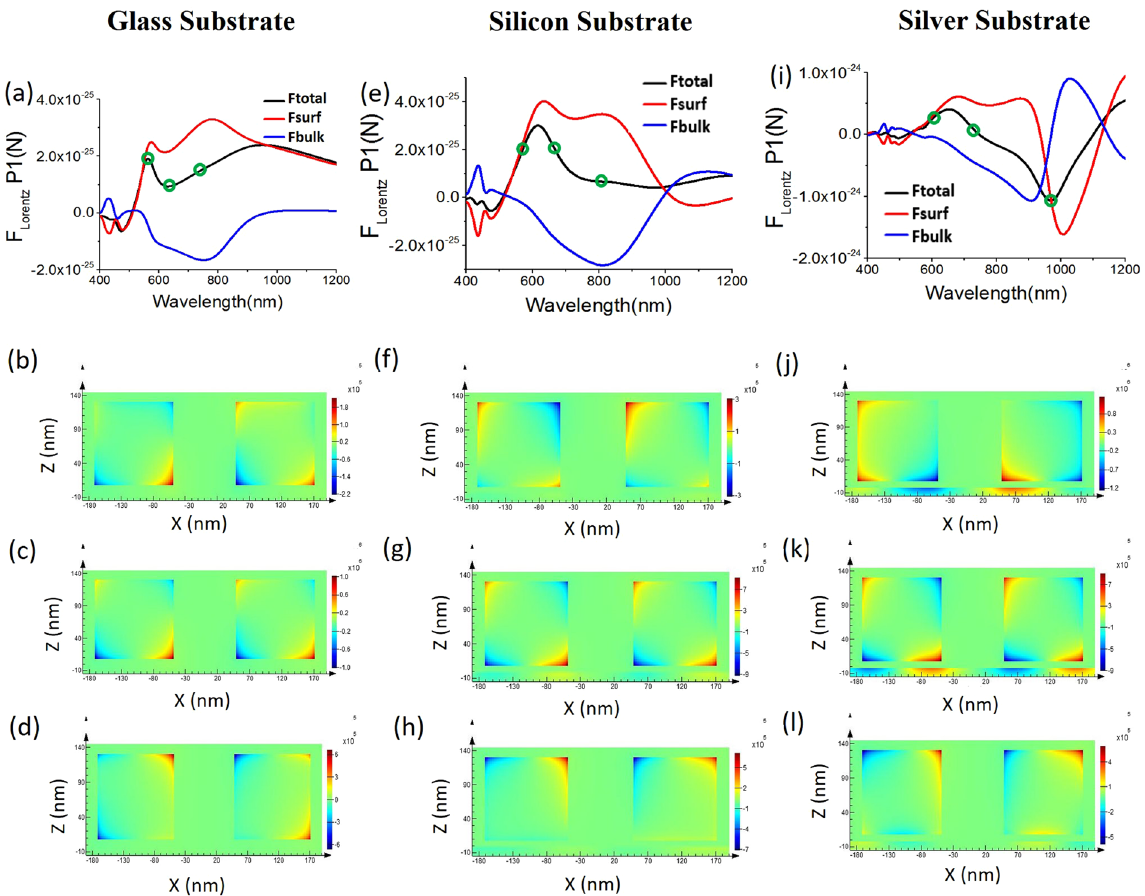
Figure 4. For the cases of different substrates, Lorentz force components and the steady state current ( J y ) of two silver cubes along with the substrate. First row represents the Lorentz force components: surface force, bulk force [cf. Eqs (5) and (6) in ‘METHODS’ section] and total force [cf. Eqs (3) and (4) in ‘METHODS’ section] only on cube-1 (left cube, denoted as P1). ‘ ° ’ represents the chosen wavelengths for which the steady state current distributions are plotted later. Second, third and fourth row represent the steady state current ( J y ) from front view [in xz plane; setting the window very close to the cube surfaces from front view] for three different wavelengths (marked as ‘ ° ’) respectively: ( a–d ) For glass substrate where wavelengths are chosen: 754, 622 and 550 nm respectively. ( e–h ) For Silicon substrate where resonance wavelengths are: 816 (DD), 679 (Fano) and 578 nm (QQ) respectively. ( i–l ) For Silver substrate where resonance wavelengths are: 966 (DD), 754 (Fano) and 627 nm (QQ)